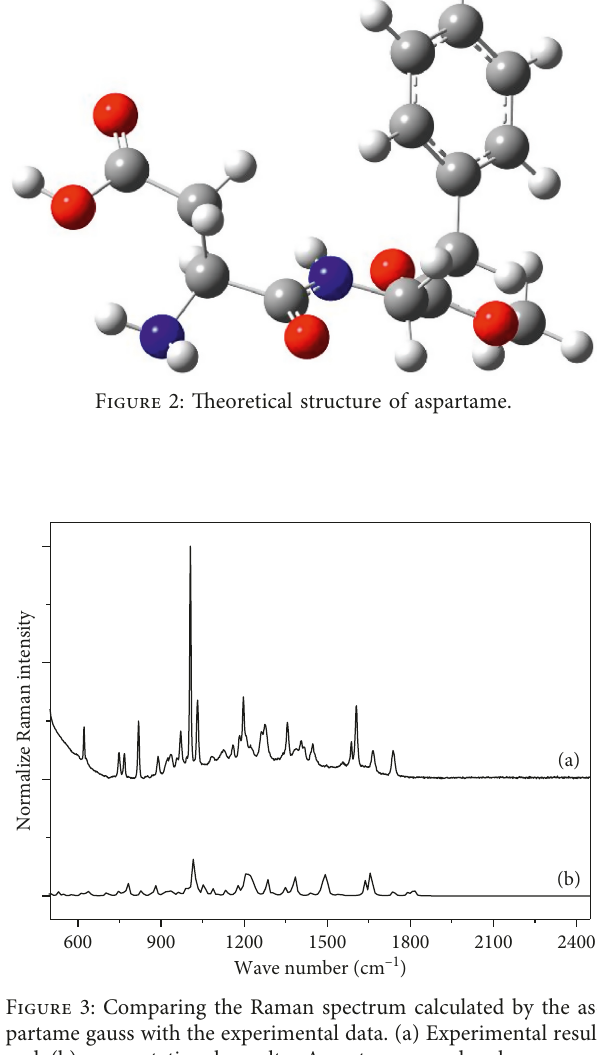
Figure 5: The effect of adsorption time on SERS intensity.